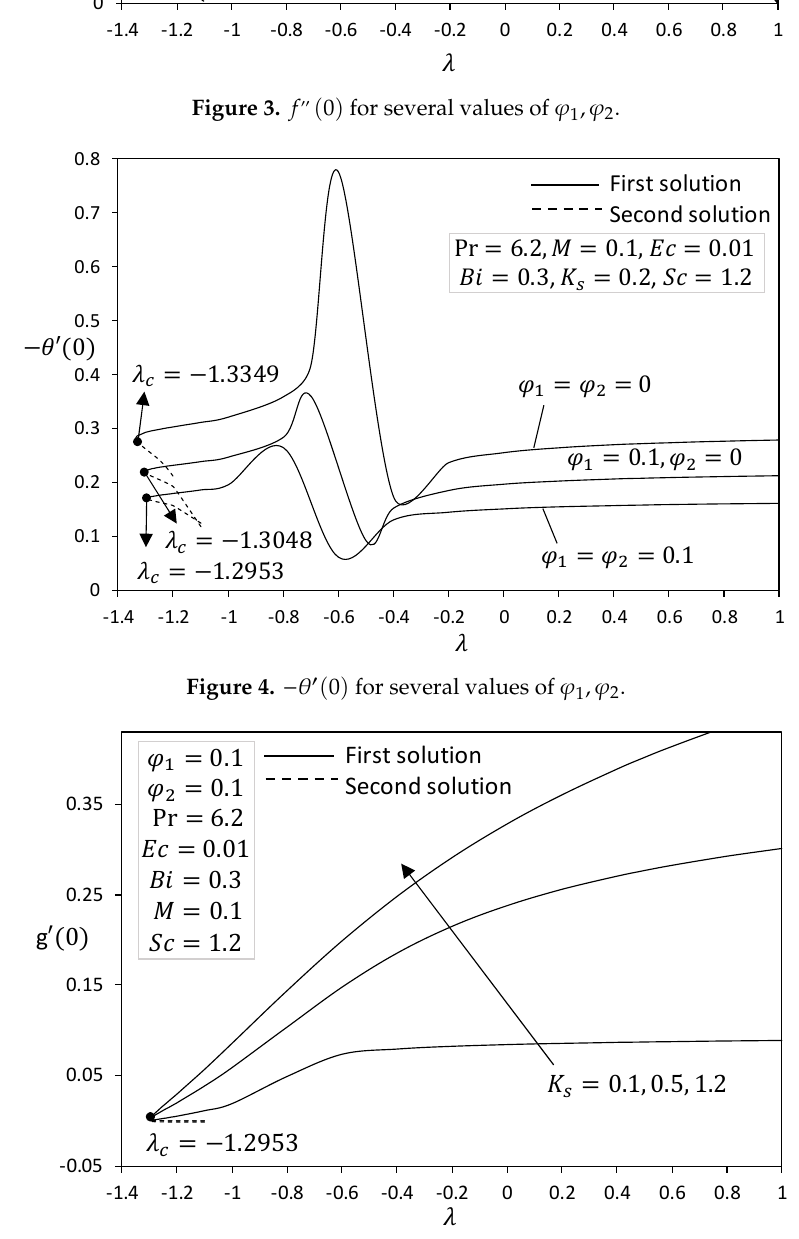
Figure 5. Concentration for several values of K s